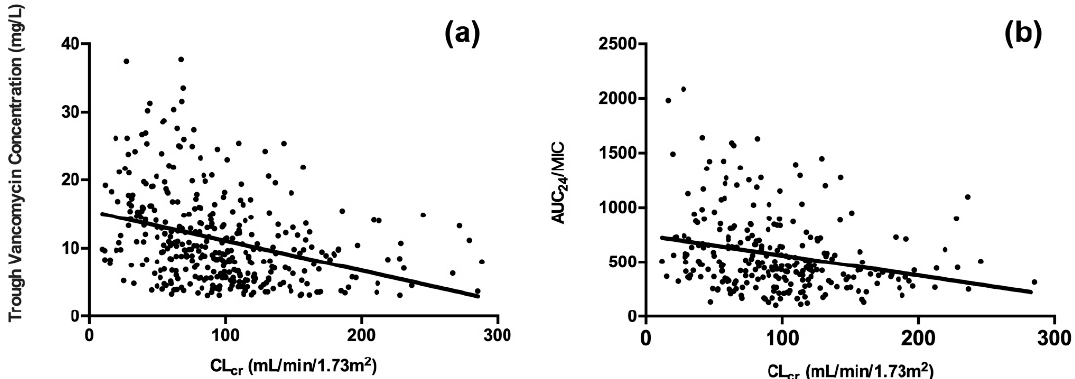
Figure 1. Correlations between vancomycin PK/PD indices and estimated creatinine clearance. ( a ):